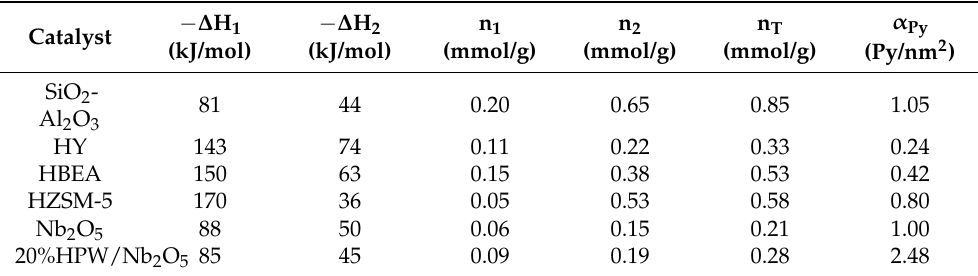
Figure 2. Distribution of specific surface areas of the aluminosilicate catalysts. Table 3. Strength of the acid sites ( − ∆ H i ) a obtained by microcalorimetry of pyridine adsorption (two-site model reaction) in cyclohexane, the total number of reactive acid sites (n T = n 1 + n 2 ) b and density of adsorbed Py ( α Py ) c